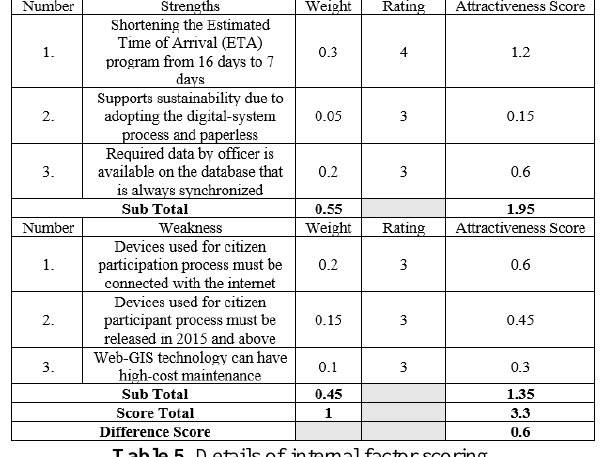
Table 5 . Details of internal factor scoring